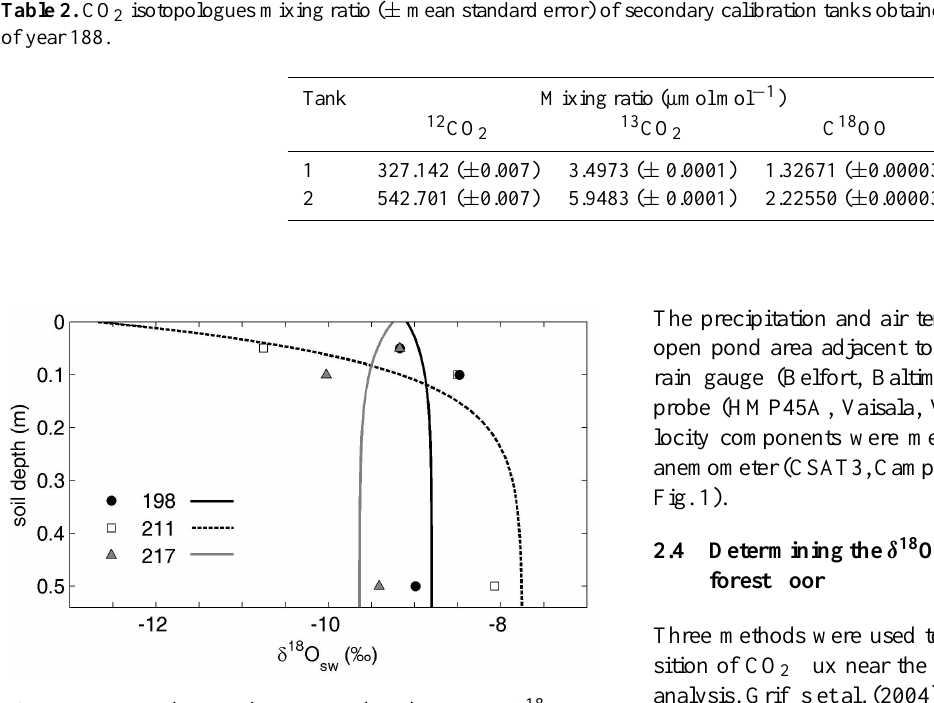
Fig. 3. Measured (symbols) and fitted (lines) profiles of 18 O val- ues for soil water ( δ 18 O sw ) for three sampling dates (day of year, DOY = 198, 211 and 217) in a temperate deciduous forest. Here δ 18 O sw is expressed in the VSMOW scale and was sampled at three depths: 0.05, 0.10 and 0.50m. Fitted curves are exponential functions with e-foldings of 5cm (DOY = 198 and 217) and 8cm (DOY =